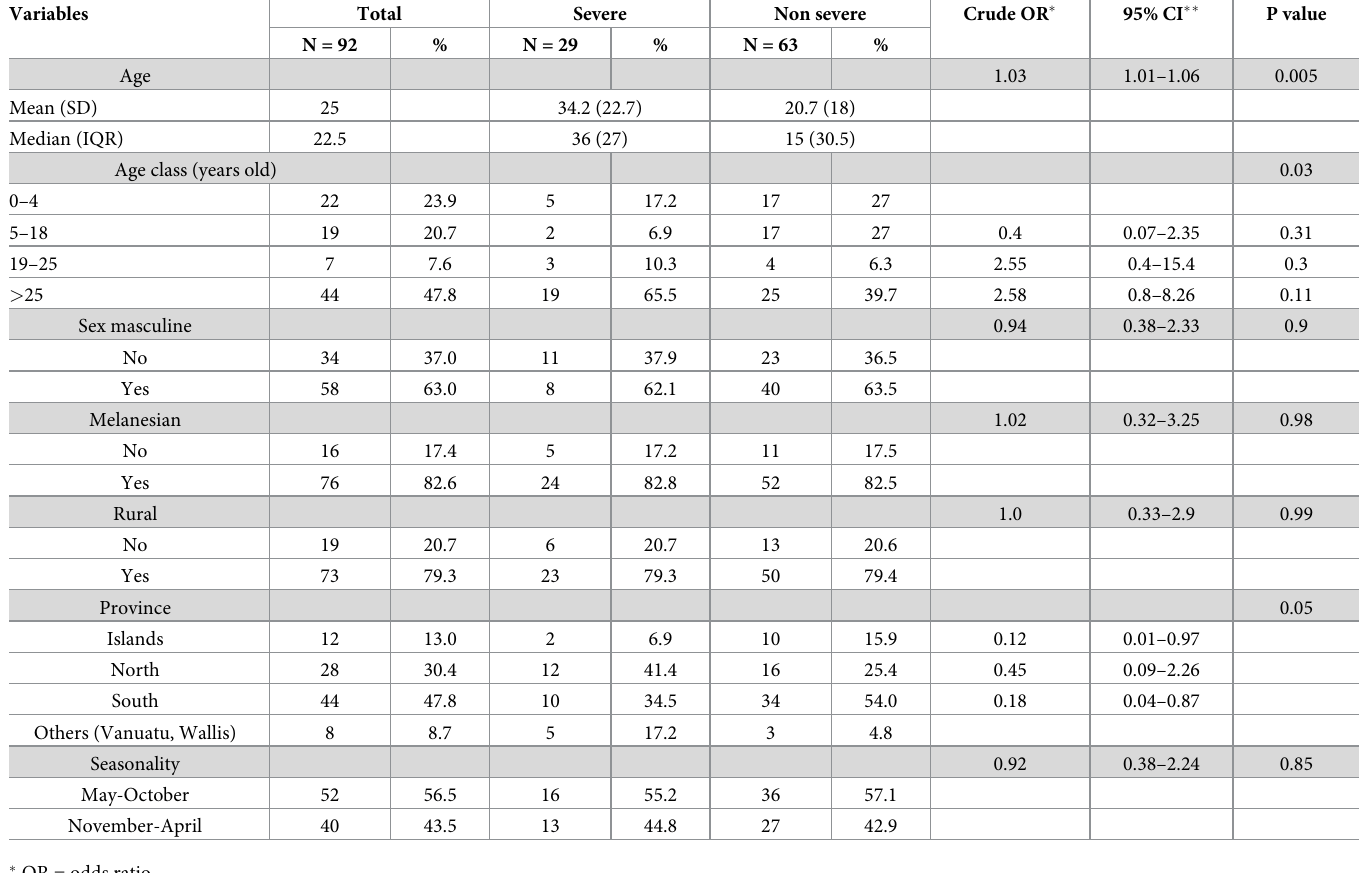
Table 1. Socio-demographical features of New Caledonian cases of EM from 2004 to 2019 according to severity, n =